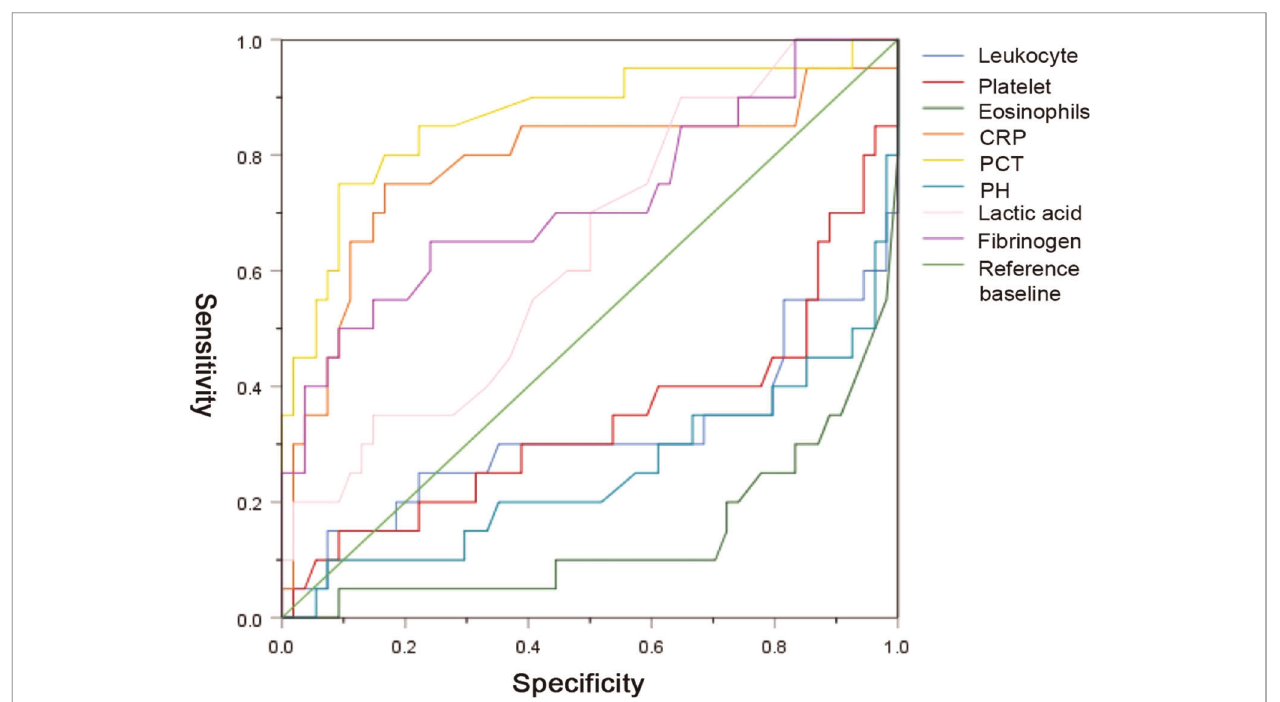
FIGURE 1 | The diagnostic values of the laboratory variables for implementing surgical treatment in patients with necrotizing enterocolitis NEC.